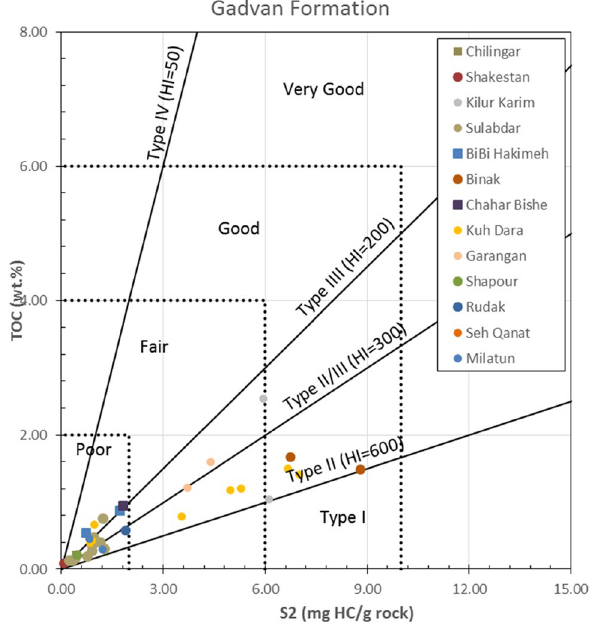
Fig. 11 S 2 versus TOC diagram of the Gadvan Formation based on available samples from the South Dezful Embayment (after Dahl et al.